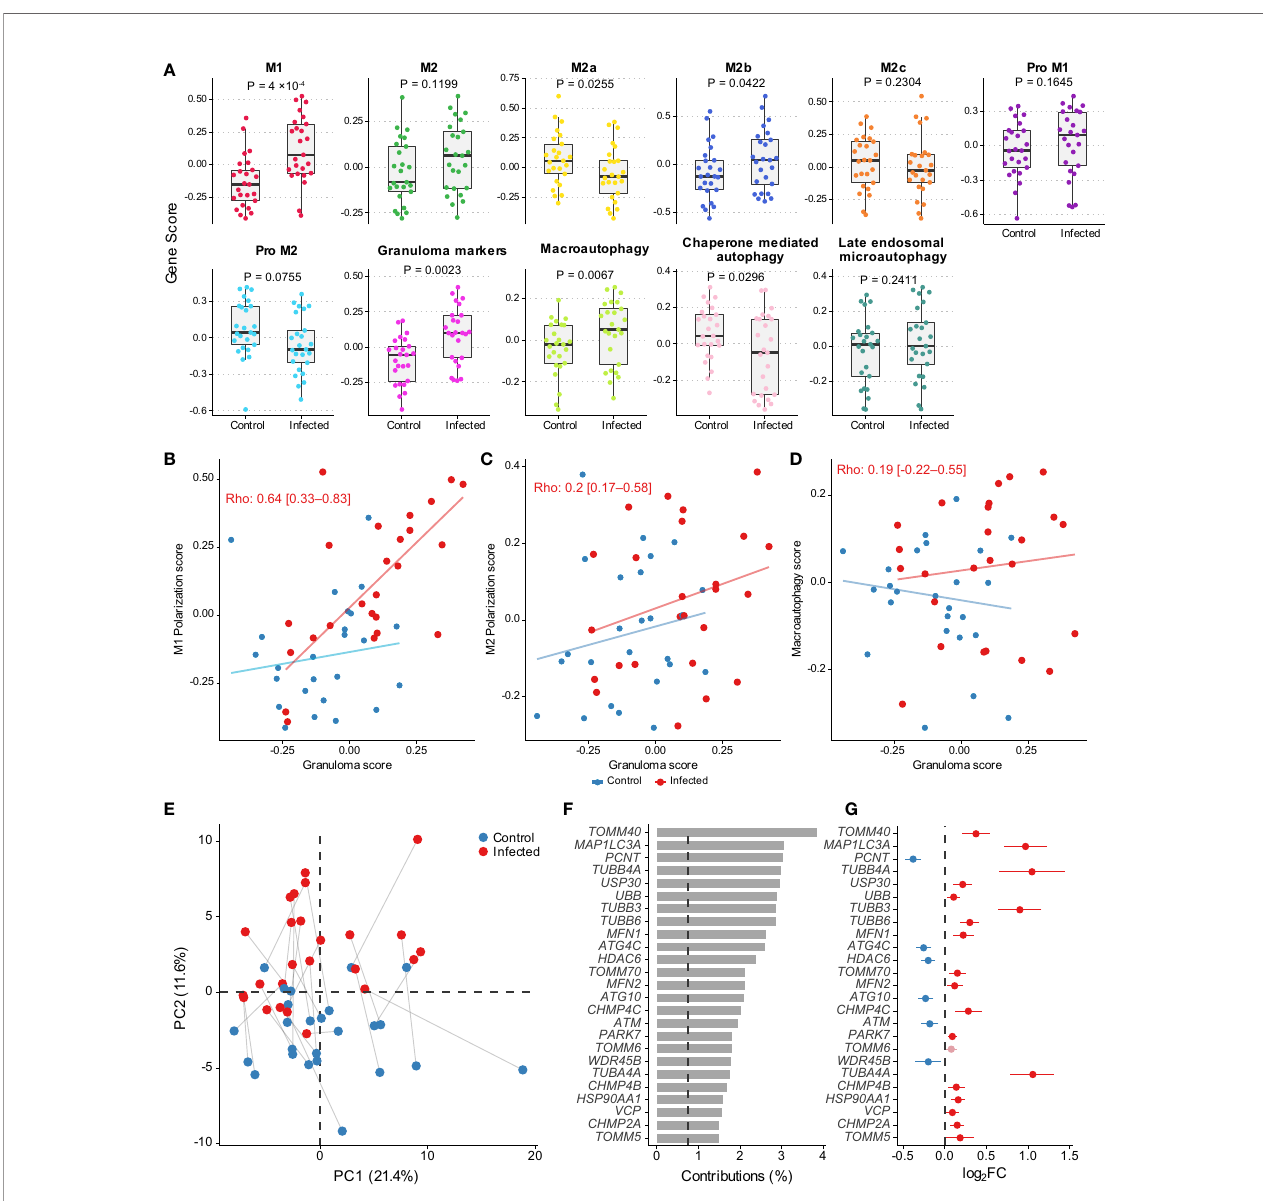
FIGURE 4 | (A) Gene scores for macrophage polarization pro fi les, granulomatosis and autophagy. Tukey box plots display fi rst, second (median), and third quartiles with whiskers extending ± 1.5 × interquartile range (IQR). Each point illustrates a MDM culture (n=50) from one human donor in mock and infected conditions (paired within donor). Nominal P-values displayed are from Wilcoxon signed-rank test. (B – D) Scatter plots illustrating the correlation between granulomatosis, M1, M2, and macroautophagy gene scores. Spearman ’ s rank correlation coef fi cient is shown with nominal 95% con fi dence intervals calculated only with the infected condition (n=25). Slope and intercept for drawing the lines were estimated using robust linear regression from the MASS v.7.3-53.1 R package. (E) Scatter plot with the two fi rst principal components from PCA on the subset of 137 macroautophagy-related genes. Lines connect samples from the same donor. (F) Percentage contribution of the top 50 genes most correlated to PC2. (G) Log 2 FC estimates from differential expression analysis for the top 50 macroautophagy-related genes from PCA and their nominal 95% con fi dence intervals. Light-shaded red indicates gene with FDR >